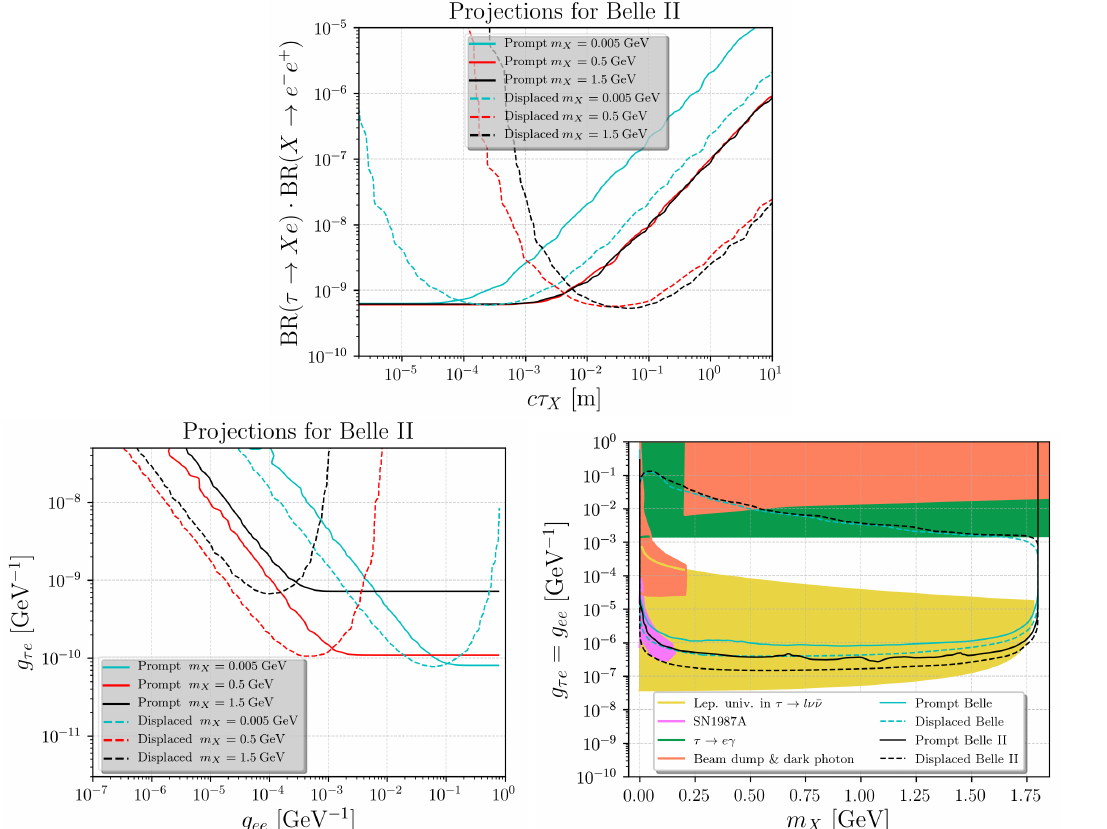
Figure 7 . Sensitivity results for Scenario 1 at 95% C.L. Top : model-independent limits on the branching-fraction product BR ( τ → Xe ) · BR ( X → e − e + ) vs. cτ X for various ALP masses. Bottom left : model-dependent bounds from Belle and Belle II on g τe vs. g ee for the prompt and displaced searches at Belle II for various ALP masses. Bottom right : bounds on the couplings vs. ALP mass in the specific case g τe = g ee , compared with bounds from lepton universality in τ → lν ¯ ν [55, 92], τ → eγ [94], SN1987A [89], beam-dump experiments [46, 47], and a dark-photon search [21, 48]. Note that the lepton-universality constraint is only valid for long-lived ALPs, resulting in the upper cutoff of the corresponding